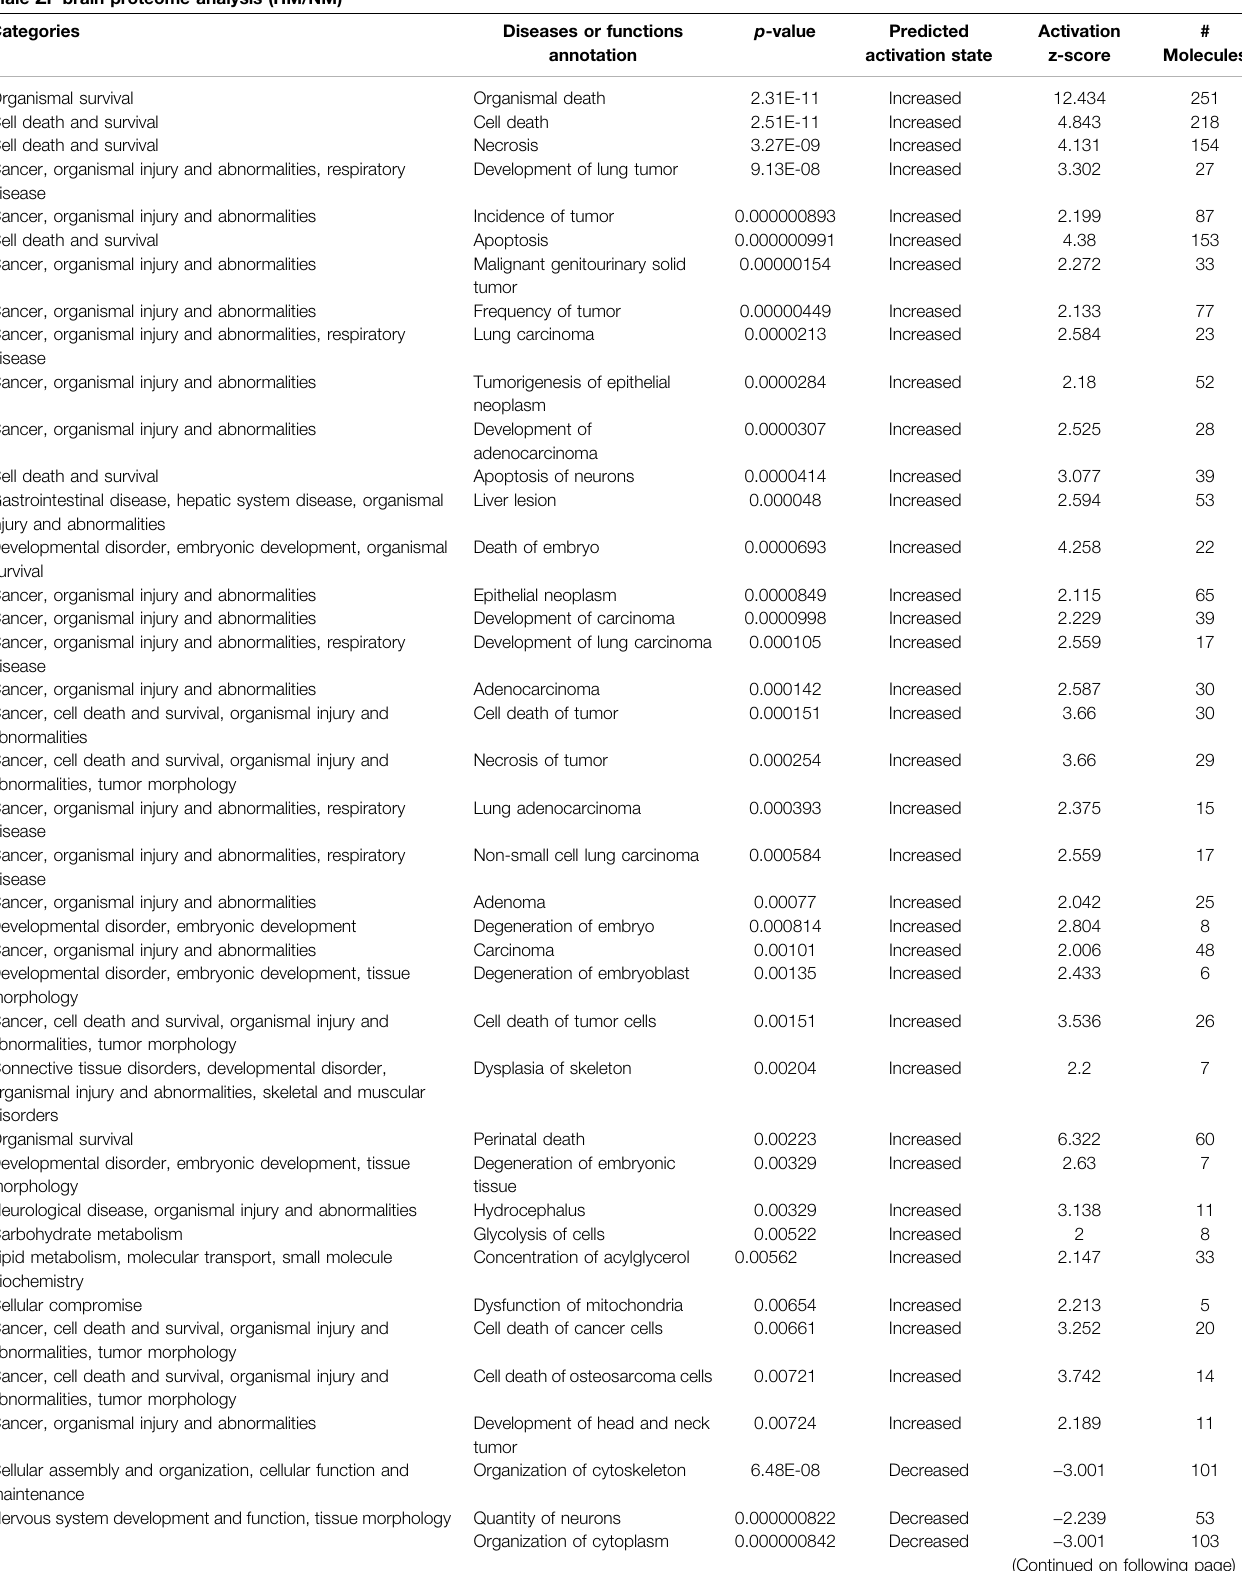
TABLE 1 | IPA generated disease function analysis for zebra fi sh male and female brain proteome induced by hypoxia following recovery. Male ZF brain proteome analysis